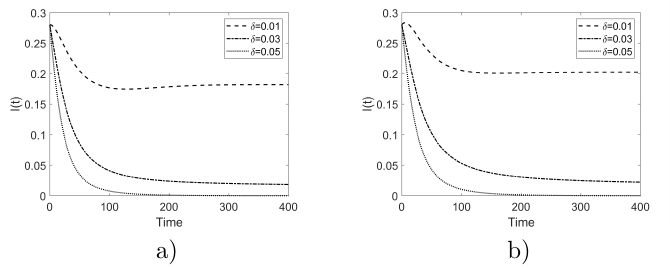
Figure 7. Evolution of I ( t ) for different values of δ in the case of (a) the network quarantine (model 1); (b) the anti-virus software quarantine (model 2), where (cid:15) = 0 . 02 ,α = 0 . 02 ,γ = 0 . 03 ,β w = 0 . 1 ,β s = 0 . 04 ,β q = 0 . 02 ,η = 0 . 02 ,µ = 0 . 004.